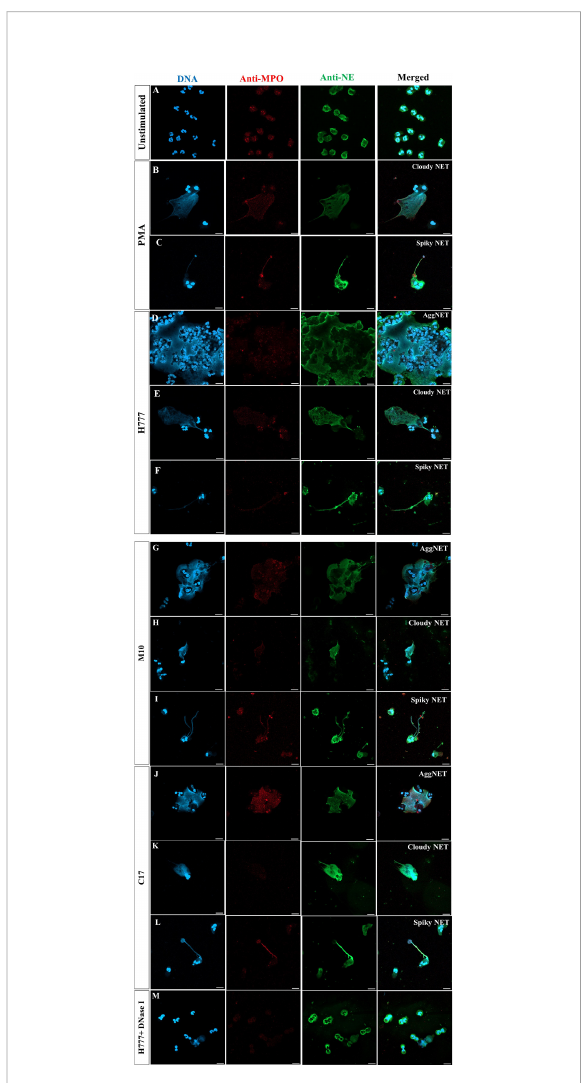
FIGURE 2 NET formation visualization and effect of DNase I degradation.